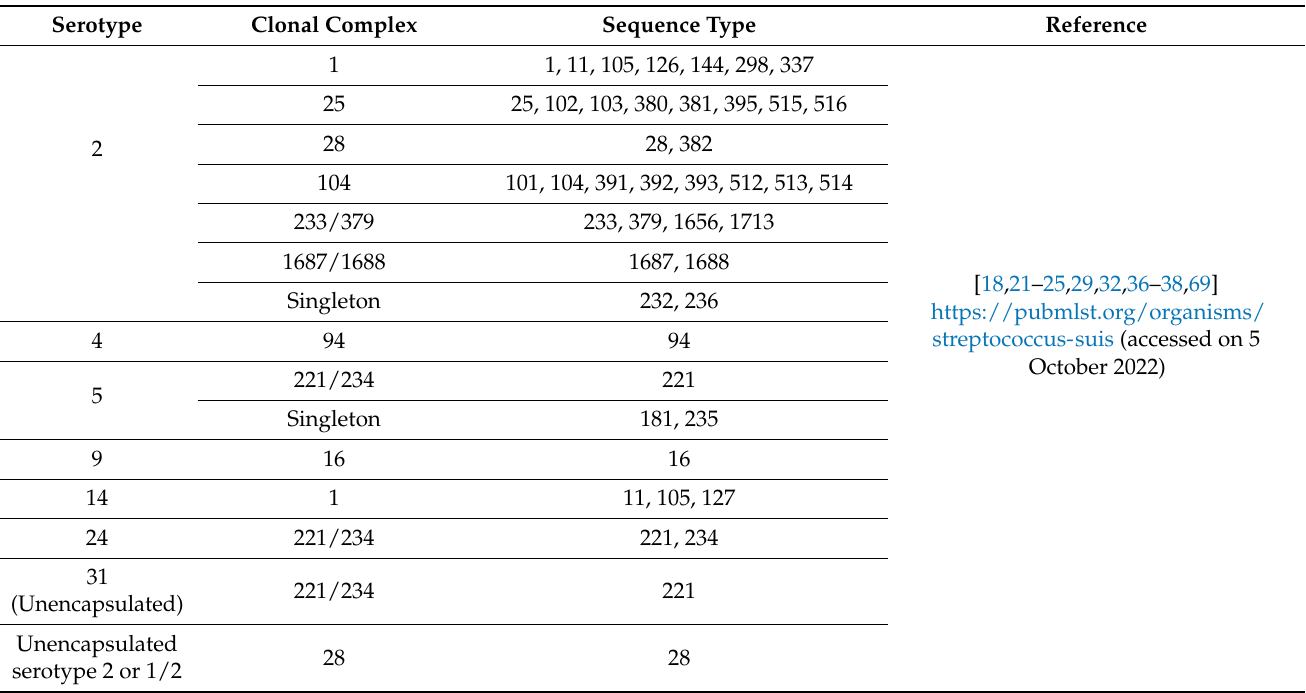
Table 2. Distribution of genotypes of S. suis isolates from